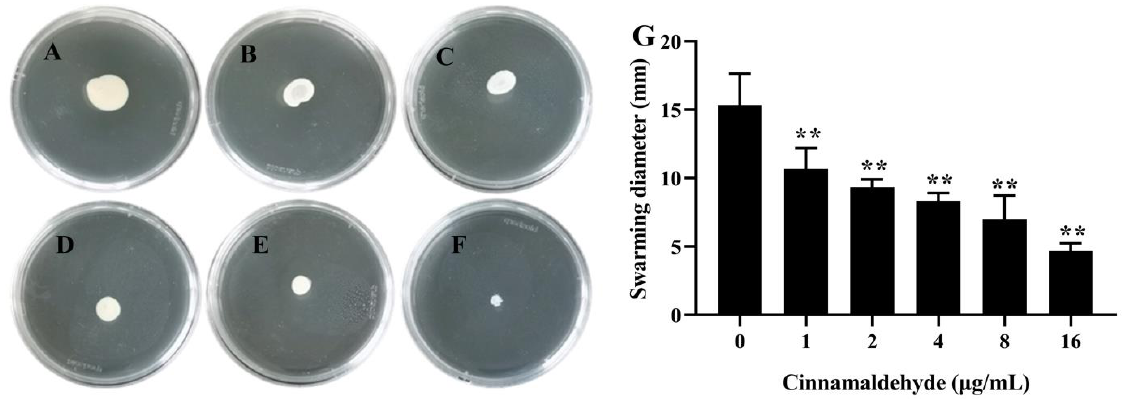
Figure 3. Effects of cinnamaldehyde on swarming motility. ( A ) DMSO control group; ( B ) 1 μg/mL; ( C ) 2 μg/mL; ( D ) 4 μg/mL; ( E ) 8 μg/mL; ( F ) 16 μg/mL; ( G ) swarming diameter. All data are presented as mean ± SD in the swarming diameter of three independent experiments. **, p < 0.01 when compared to the DMSO group.